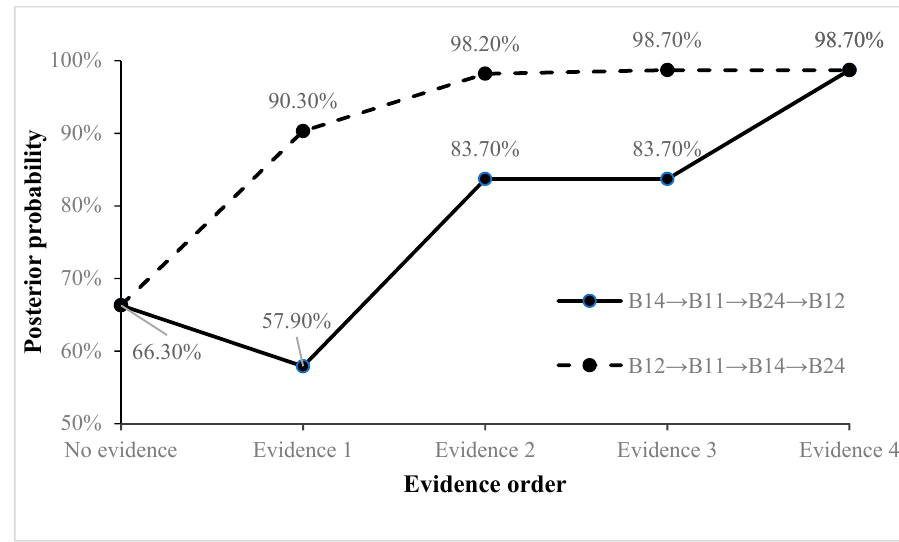
Figure 4. The change in the trend of the posterior probabilities of F.